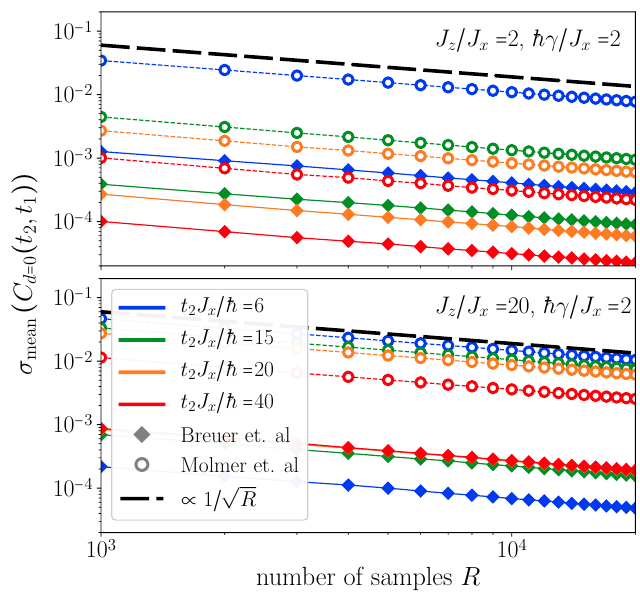
Figure 10: Standard deviation of the mean of the two-time correlation function in dependence of the number of Monte-Carlo samples R measured at four different > t times t . The black dashed line is a guide to the eye and data is shown for 2 1 / J = 2 (top panel) and J the interaction strengths J z x = 2, t / (cid:126) = 5, an exact MPS representation and a time step of L = 14, (cid:126) γ/ J J x x 1 ∆ tJ / (cid:126) = x